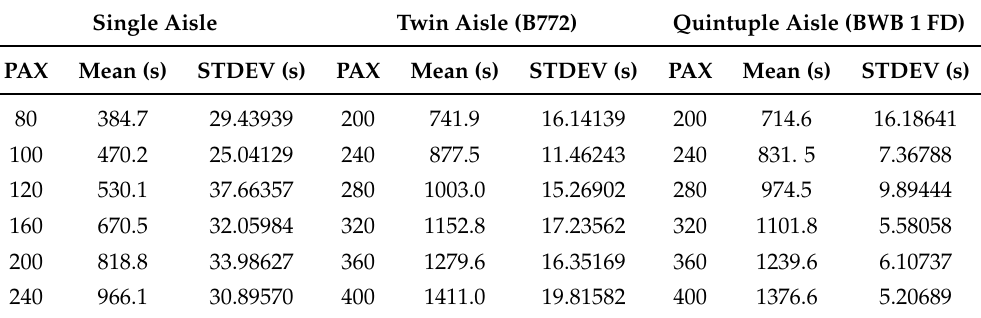
Table 4. Comparison of boarding times for different aircraft cabin layouts (PAX: passenger, STDEV: standard deviation, FD: front door).